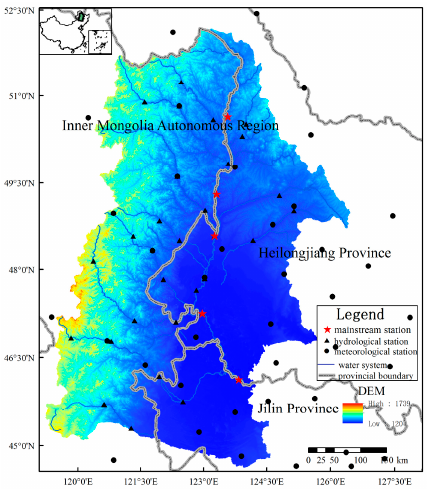
Figure 1. Location of the study area, and distribution of hydrological and meteorological stations.